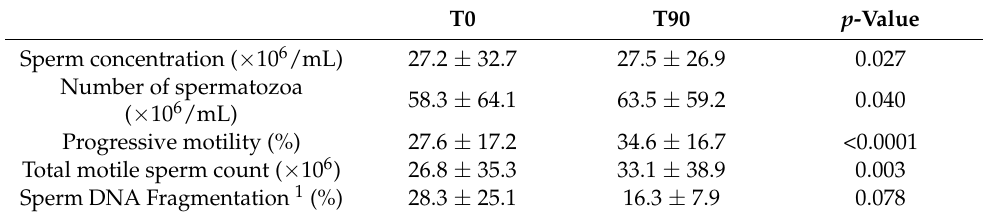
Table 2. Sperm parameters assessed in 77 patients before and after treatment.